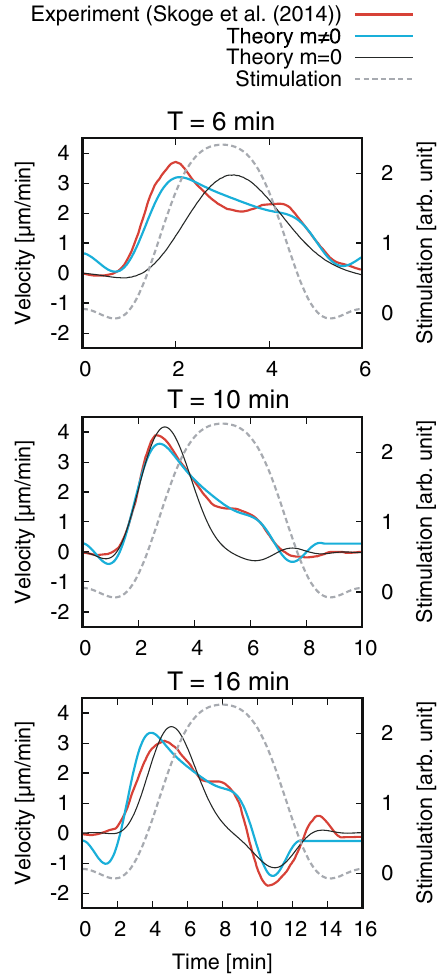
Figure 2. Instantaneous velocities obtained experimentally 8 and theoretically. Parameter values are ( T = 6 min ) m = 4 min , α = 0.5 , β = 0.2 min , χ 0 = 1639 , and σ = 0.94 ; ( T = 10 min ) m = 3 min , α = 0.5 , β = 0.5 min , χ 0 = 743 , and σ = 1.16 ; and ( T = 16 min ) m = 6 min , α = 0.5 , β = 0.3 min , χ 0 = 1137 , and σ = 1.29 . For the results of m = 0 , ( T = 6 min ) α = 0.7 , β = 0.7 min , χ 0 = 295 , and σ = 0.50 ; ( T = 10 min ) α = 0.4 , β = 4.1 min , χ 0 = 201 , and σ = 0.93 ; and ( T = 16 min ) α = 0.8 , β = 1.7 min , χ 0 = 200 , and σ =